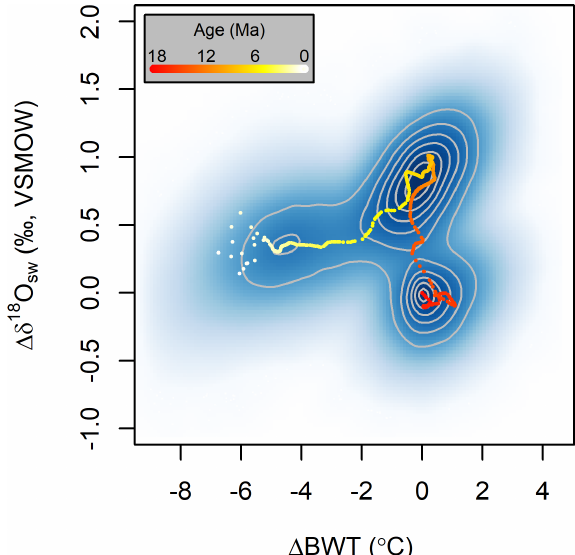
Figure 9. Bivariate density plot of posterior values from the site 806 environmental time series models (base 50kyr time steps only). All values are plotted as change relative to 18Ma within an individual posterior sample. Dots show the median values from the posterior time